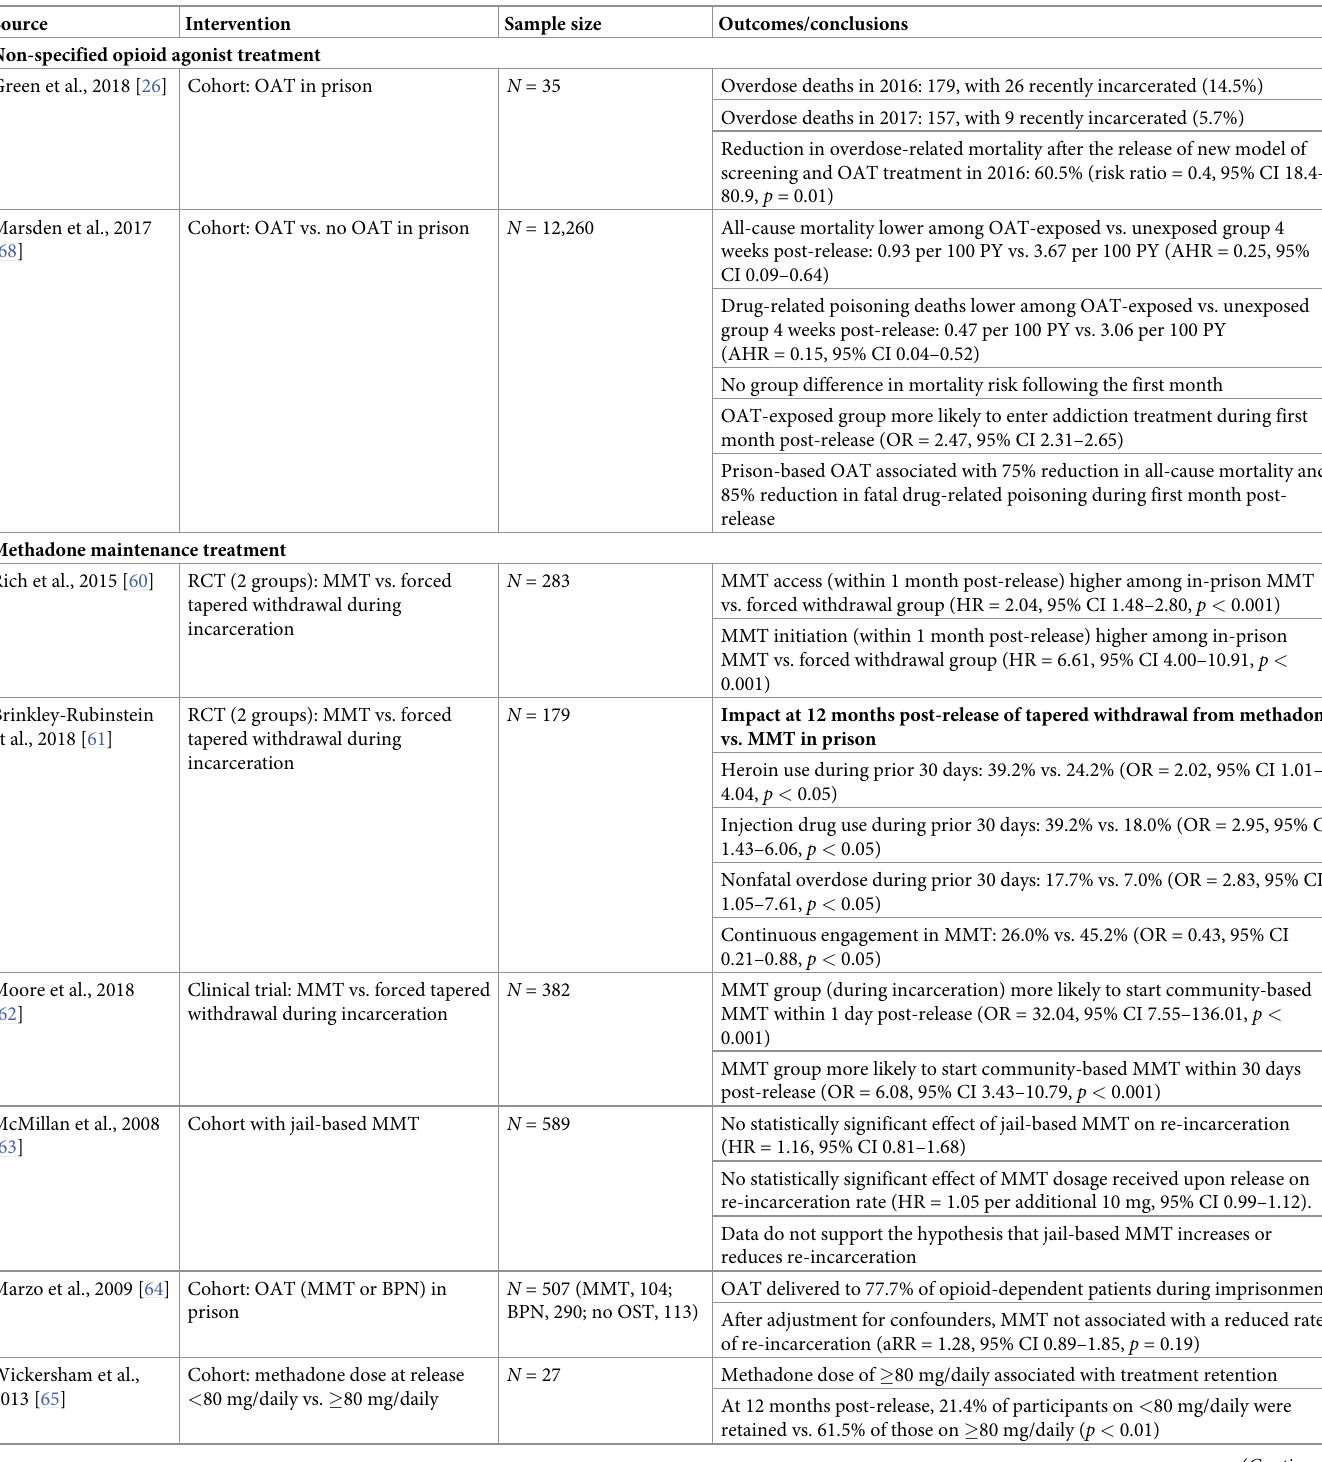
Table 3. Description of intervention and related outcomes of opioid use interventions during incarceration,